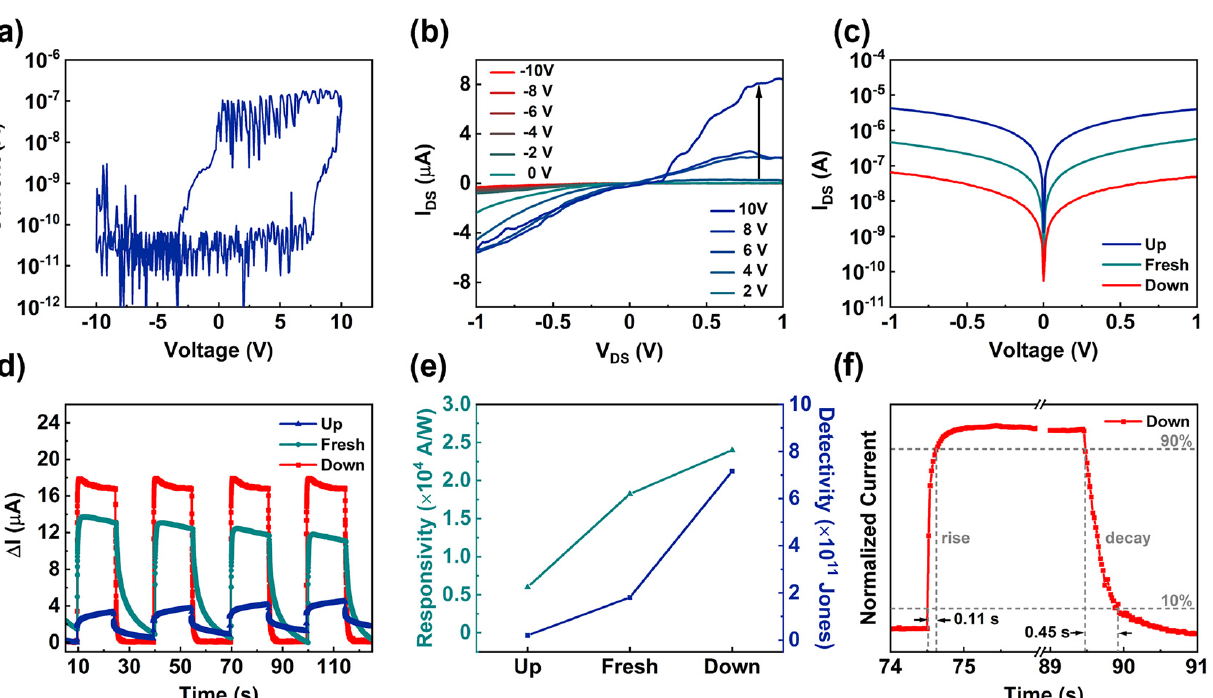
Figure 2. ( a ) Transfer characteristic curves of the ZnO NW Fe–FET device with a CIPS ferroelectric gate at V DS = 0.1 V. ( b ) The I DS –V DS output characteristic curves of the device using remanent polarization when CIPS were polarized with − 10 V to +10 V gate voltages and the gate voltage was removed. ( c ) The I DS –V DS output characteristics with three ferroelectric layer states. ( d ) The ∆ I–t characteristic curves with three ferroelectric layer states when V DS = 0.1 V. ( e ) The responsivity and detectivity of the device in three states. ( f ) The response time of the device at a power intensity of 50 mW/cm 2 in the Down state.